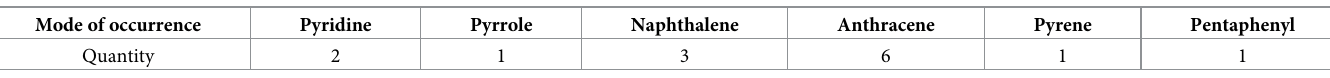
Table 5. Existence form of aromatic carbon in the anthracite